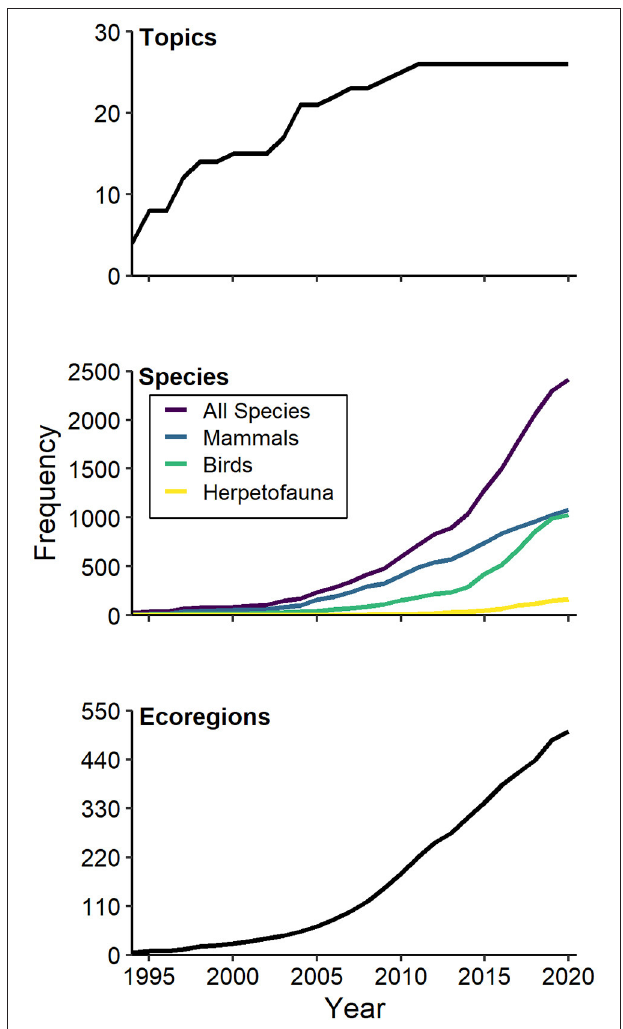
FIGURE 3 | Accumulation of topics, species, and ecoregions in camera-trapping articles, 1994–2020.